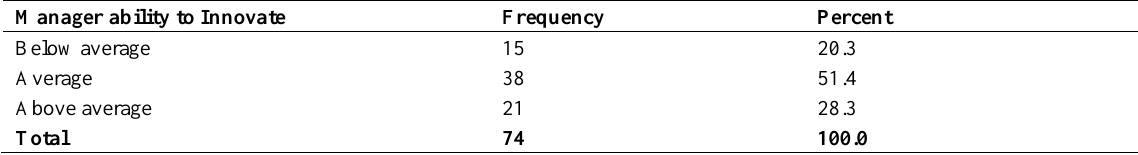
Table 5: Parents rating of their School Manager’s